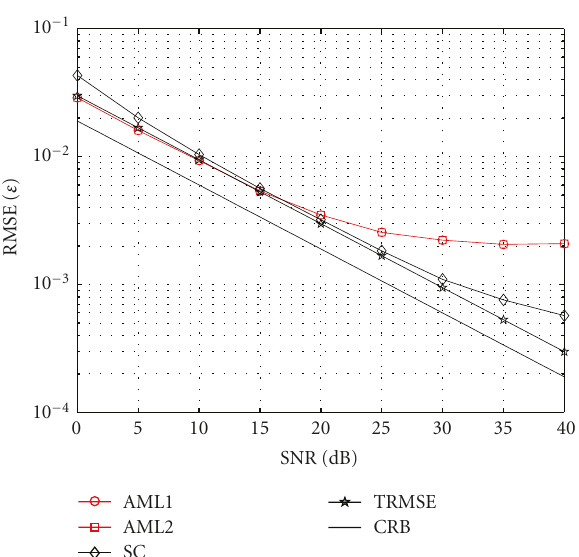
Figure 4: Performance of the considered CFO estimators in ITU Vehicular A multipath channel.